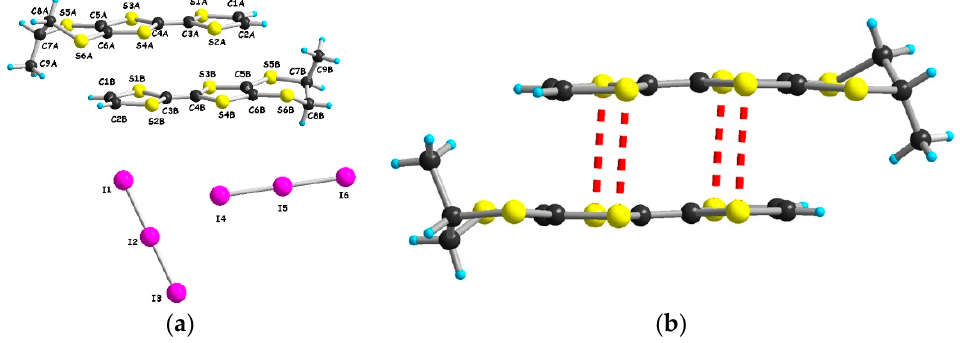
Figure 6. ( a ) Molecular structure of [( S )- 1 ]I 3 together with the atom numbering scheme; ( b ) Dimer motif in the structure of [( S )- 1 ]I 3 with emphasis on the S···S short contacts: red dotted lines for 3.34, 3.37, 3.38 and 3.42 Å.